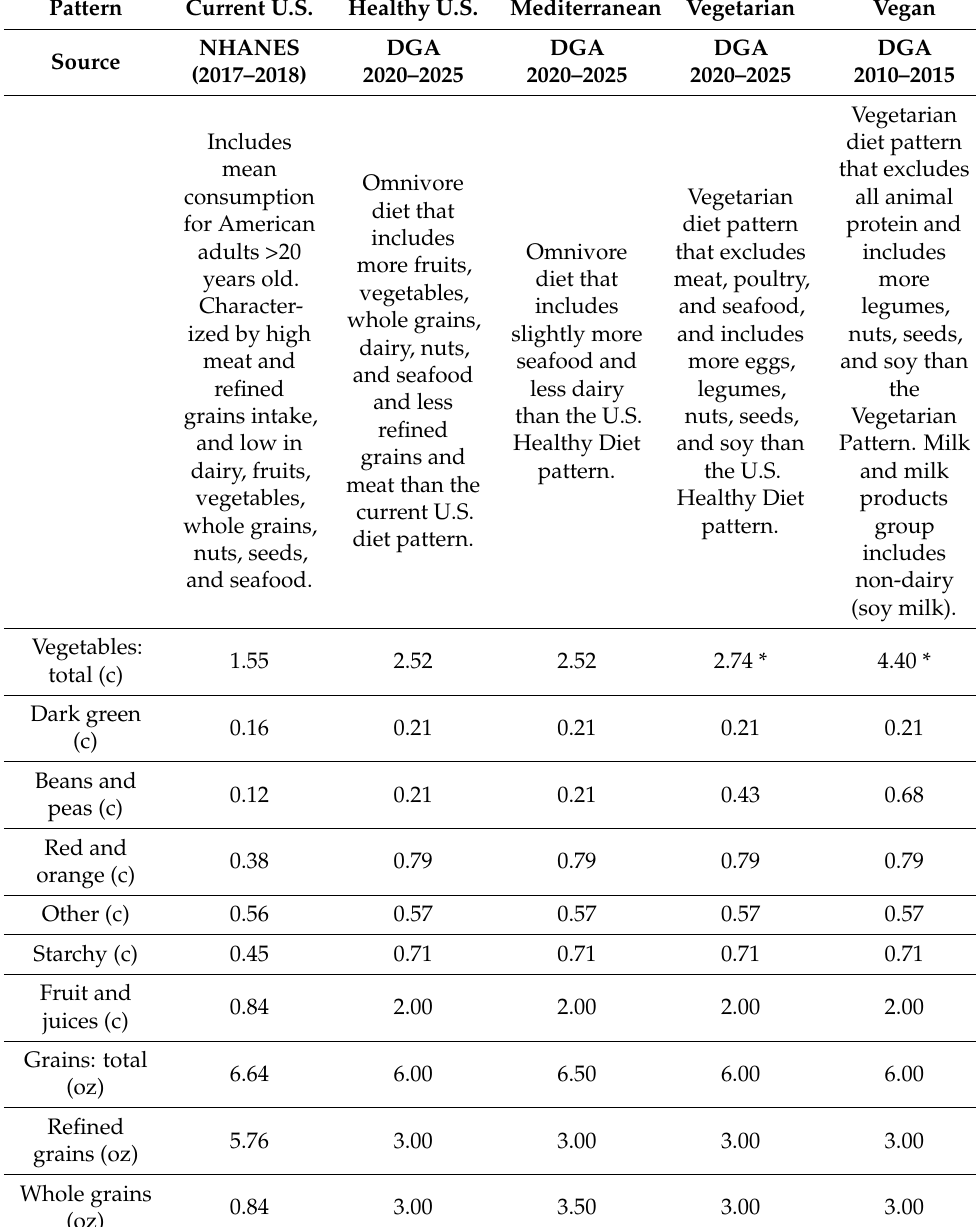
Table 1. Dietary Pattern Comparison: Current U.S., Healthy U.S., Mediterranean, Vegetarian, and Vegan Food Patterns; USDA diet pattern quantities reflect recommendations for a 2000 kcal level diet. Values are servings (units indicated by dietary item, first column) per day. Pattern Current U.S. Healthy U.S. Mediterranean Vegetarian Vegan Source